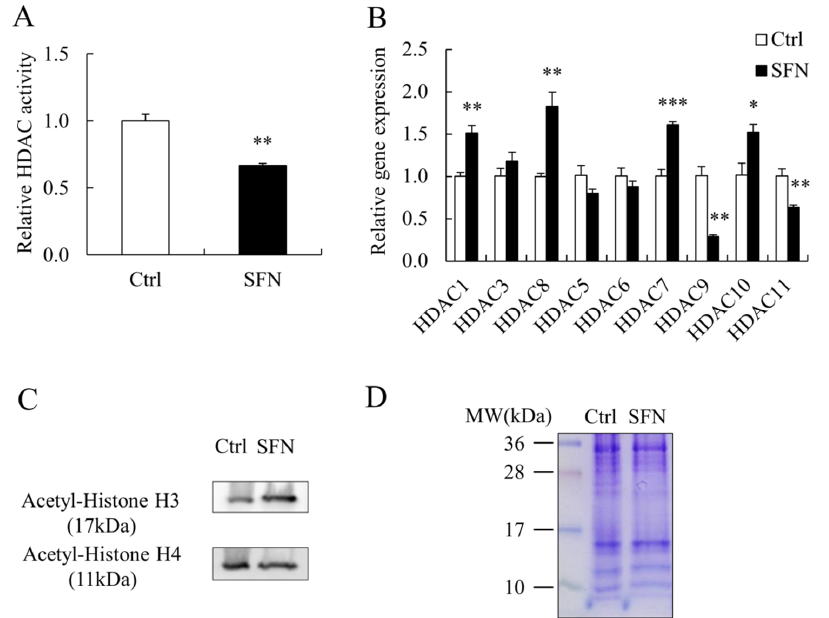
Figure 3. SFN increased global histone acetylation in PSCs. ( A ): The HDAC activity in Ctrl and SFN treated PSCs; ( B ): HDAC family members’ relative mRNA expression levels; ( C ) and ( D ): Western blot results of acetylated histone H3 and H4 in PSCs treated with Ctrl and SFN, and Coomassie-Brilliant Blue staining as loading control. Data are shown as the mean ± SE and assays were done in triplicates. * p < 0.05, ** p < 0.01, *** p < 0.001.